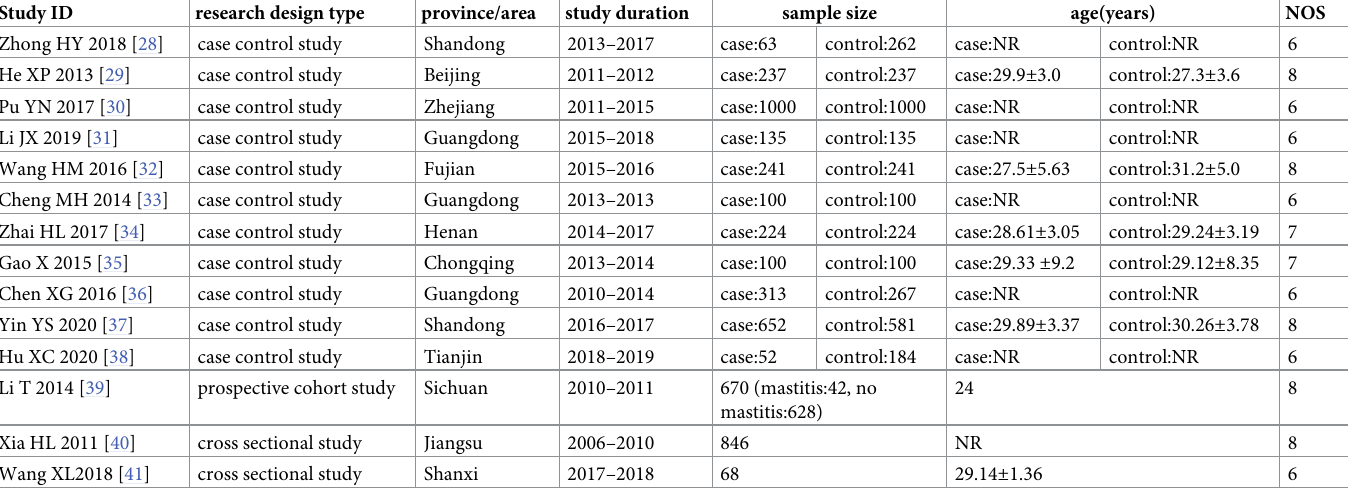
Table 1. Basic information of the included studies.